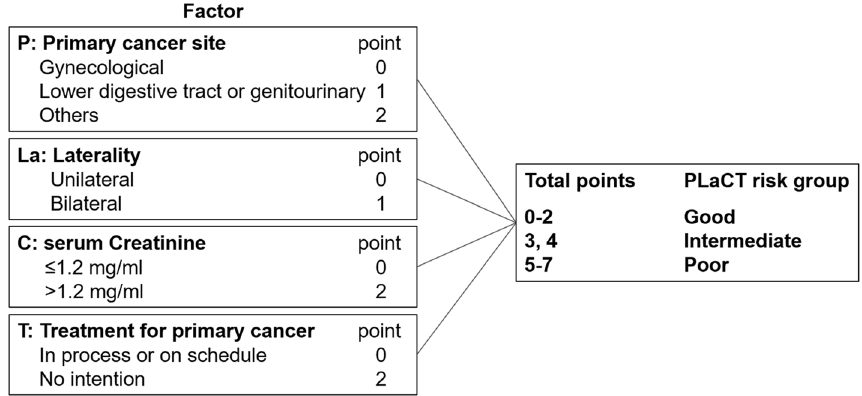
Figure 1. Scoring for PLaCT risk classification. Patients were divided into three risk groups (good, intermediate, and poor) based on the score calculated using four prognostic